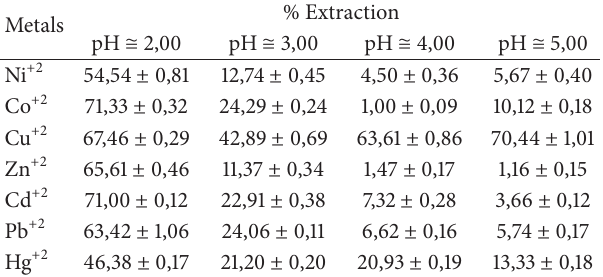
and [metal nitrate] = 1 × 10 − 2 M, 298K, 1h contact time. Averages and standard deviations calculated for data are obtained from five independent extraction